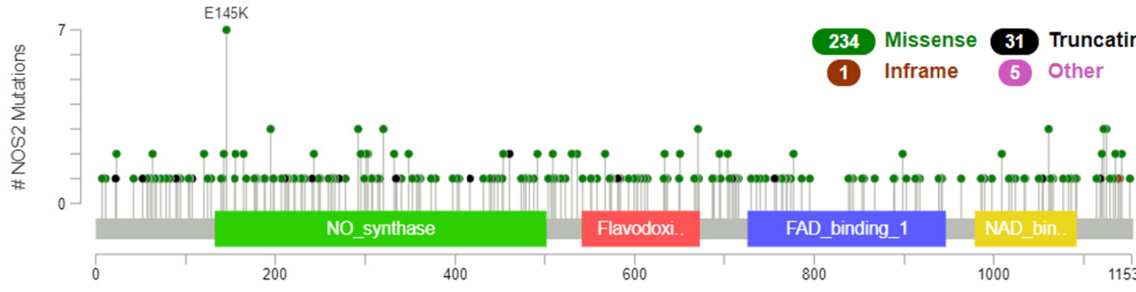
Figure 3: iNOS/NOS2 gene mutation type and location analysis.